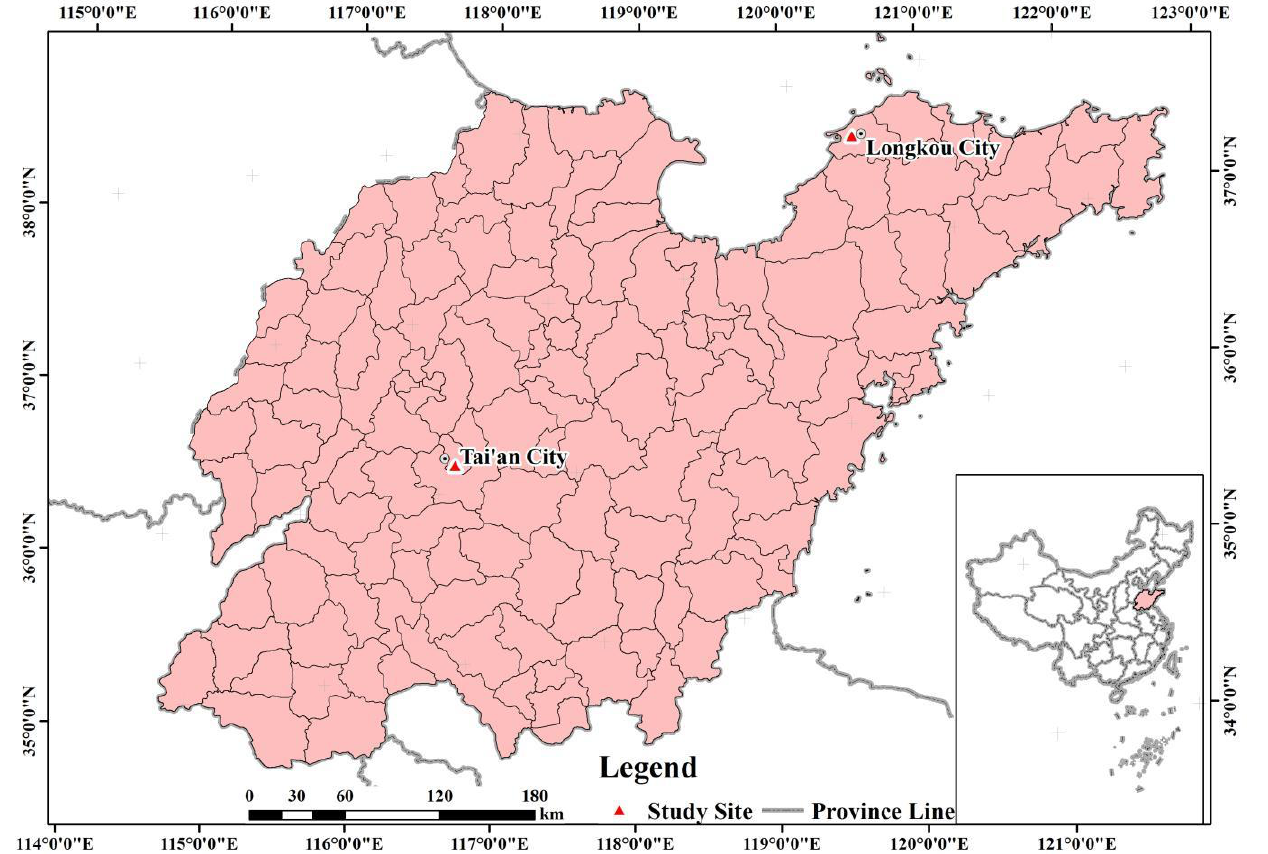
Figure 1. The locations of the Tai’an and Longkou experimental sites.